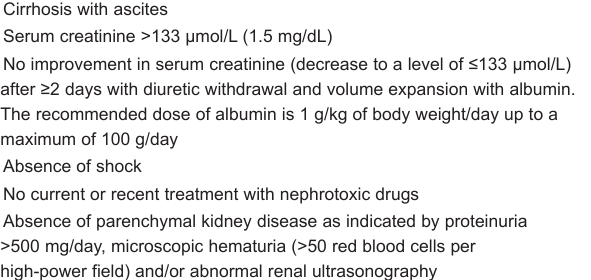
TABlE 2 Revised diagnostic criteria for hepatorenal syndrome (International Ascites Club,